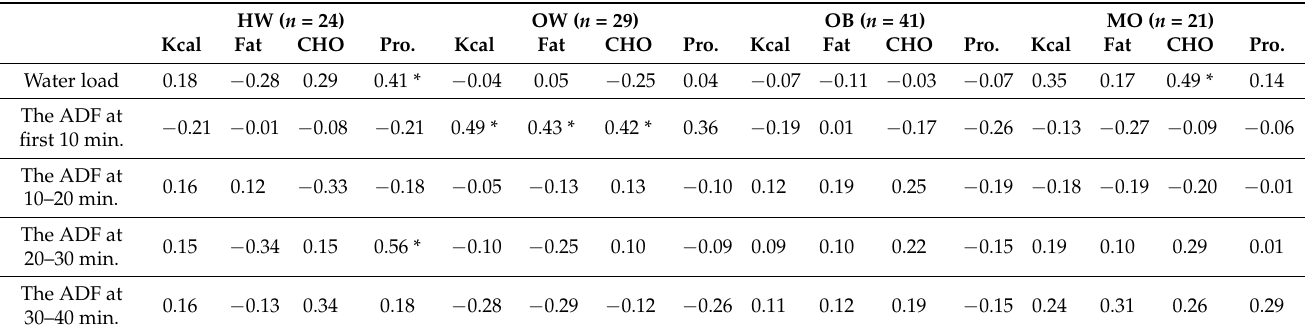
Table 4. Pearson correlation coefficient between dietary intake and gastric myoelectrical activity among subgroups, n =